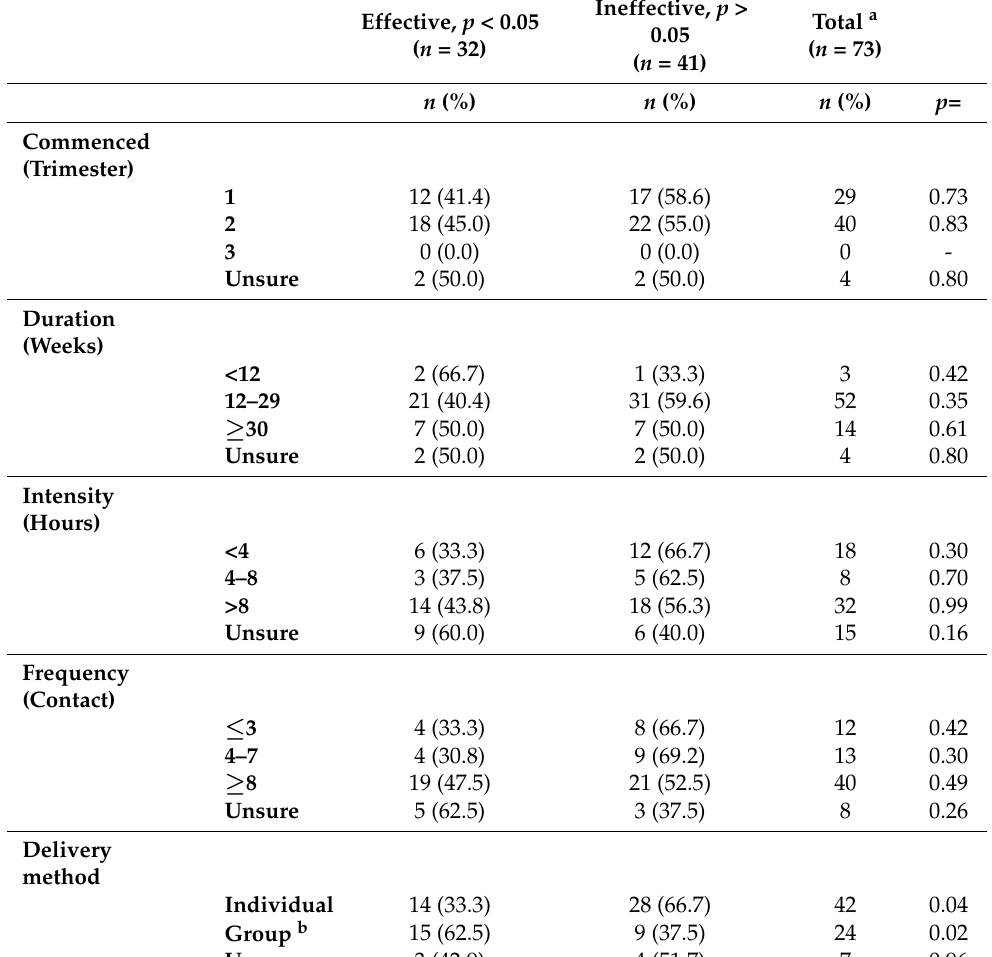
Table 3. Summary of the effectiveness of interventions according to